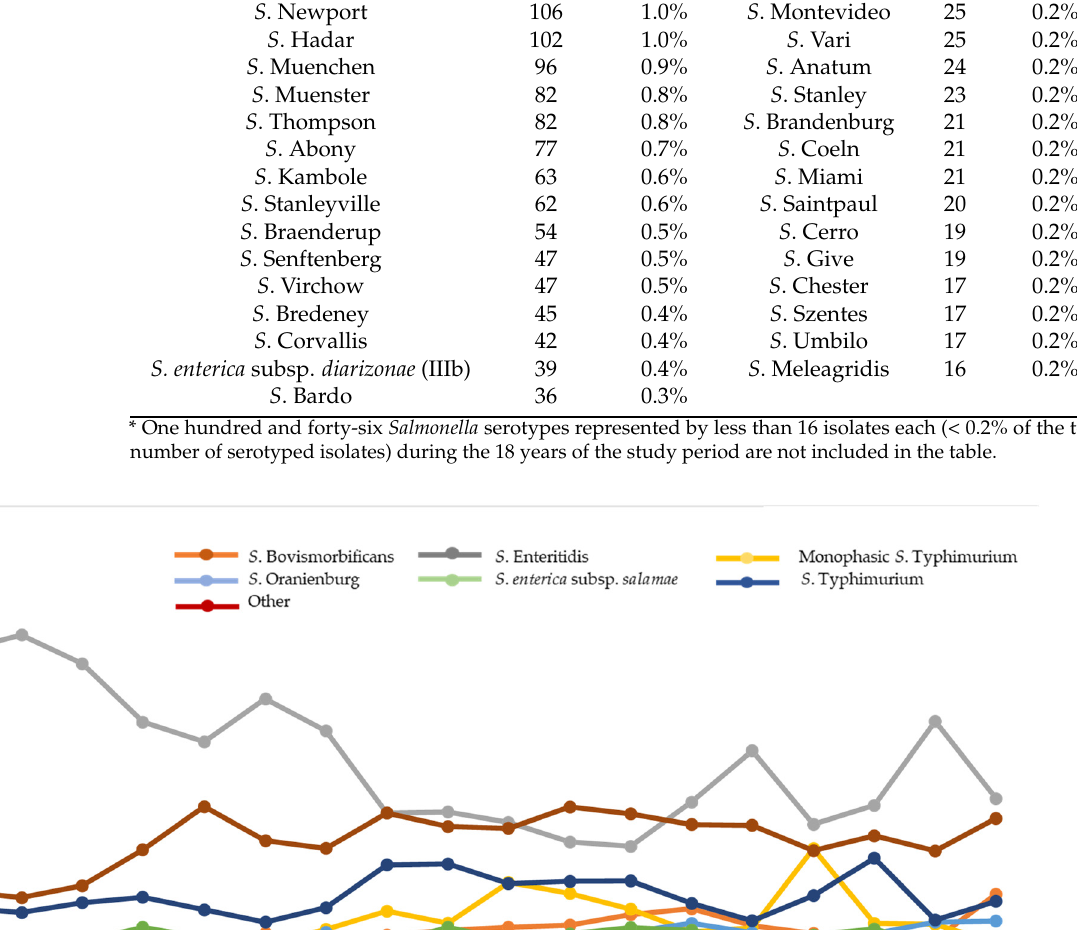
Table 2. Distribution of the Salmonella spp. serotypes by age groups of the persons whose specimens yielded isolates, 2003–2020, Greece ( N = number, % = percentage). Age Group S . Enteritidis